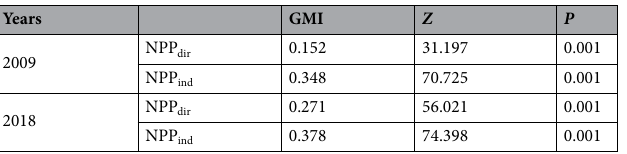
Table 2. The global Moran’s I of NPP dir and NPP ind in 2001, 2009, and 2018. NPP dir is the direct impact of urbanization on NPP and NPP ind is the indirect impact of